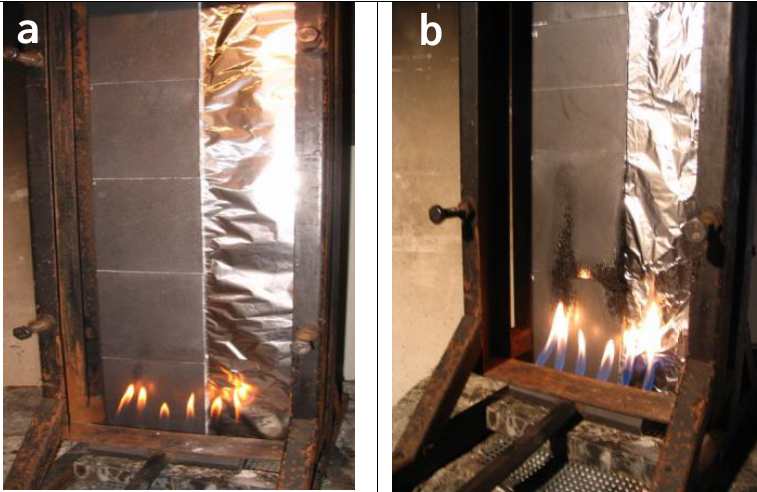
Figure 17. Example (sample PP + 5%Gra + 5%AlPh + 5%MMT) of a flame treatment based on the Schlyter test at different times after the start ( a ) and after few minutes ( b ) of the flame treatment.